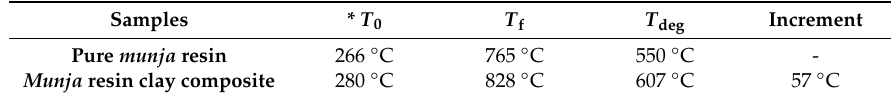
Table 3. TGA results of phenol-furfural ( Munja) resin and phenol-furfural ( Munja) resin / organo modified MMT clay composite.